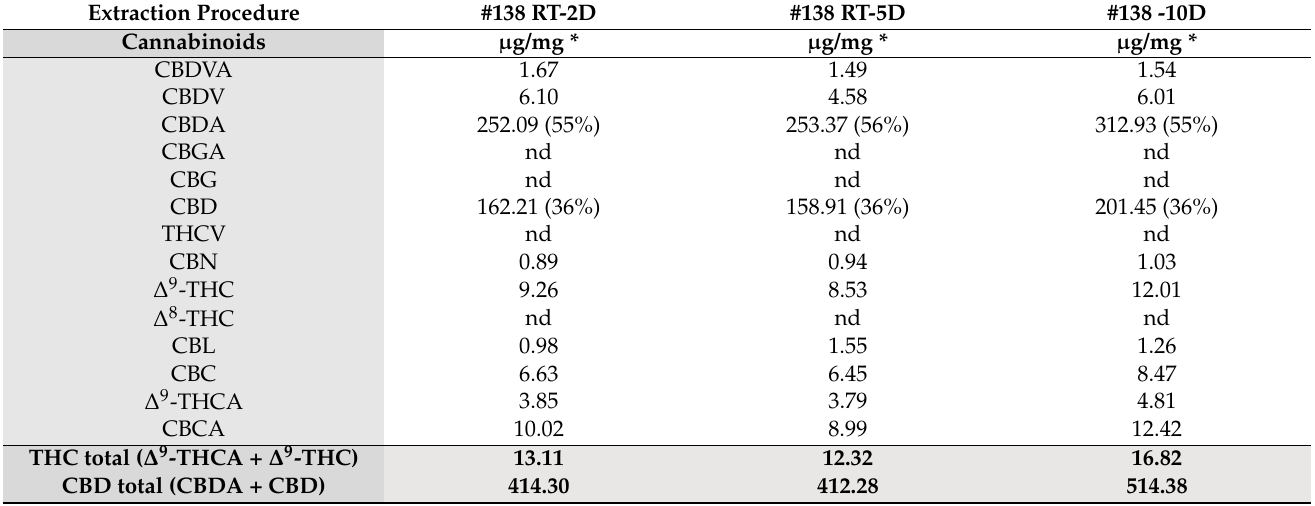
Table 1. Identification and quantification of cannabinoids for 3 different ethanolic extraction procedures of #138. Mean values for two independent injections. With RT = room tempera- ture; 2D = two days; 5D = five days; − 10D = − 20 ◦ C for 10 days. Data generated by LCA, INRAE,